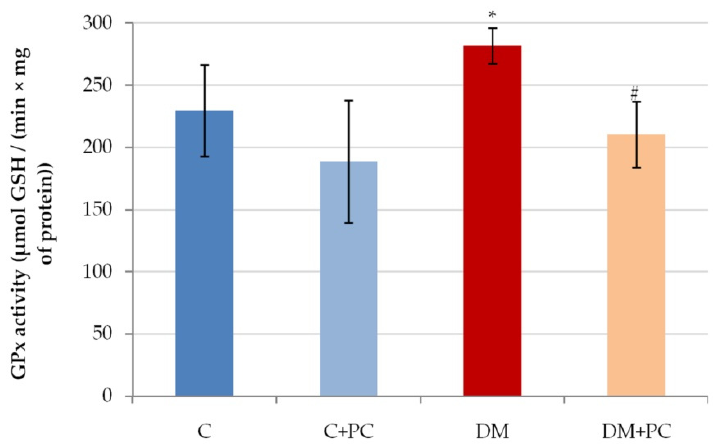
Figure 13. The activity of glutathione peroxidase in plasma of control rats, rats with experimental diabetes mellitus, with and without PC concentrate. C–normal untreated control animals; C + PC–animals that were per os administrated PC concentrate (daily dose of 45 mg/kg bw of polyphenolic complex for 14 days); DM–rats with experimental diabetes mellitus; DM + PC–animals with experimental diabetes mellitus that were per os administrated PC concentrate (daily dose of 45 mg/kg bw of polyphenolic complex for 14 days). *-significant difference compared to control ( p < 0.05); #-significant difference compared to diabetes mellitus ( p <